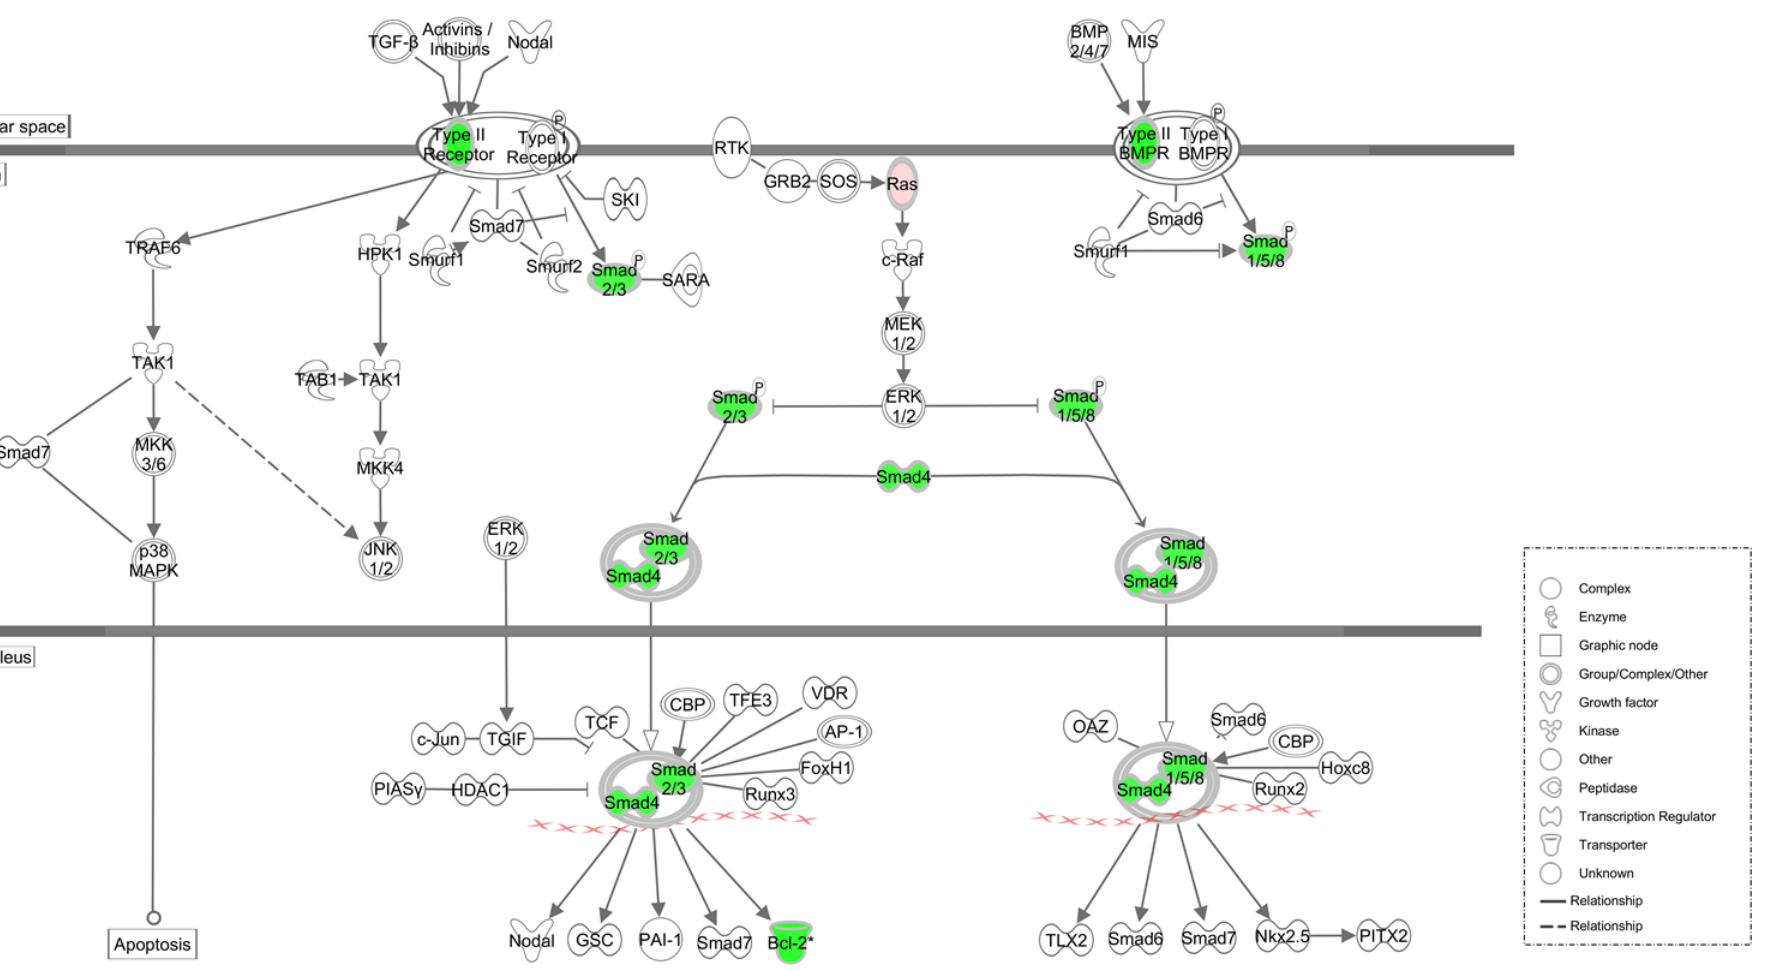
Figure 4. Schematic diagram of TGF-β and BMPs signaling pathways in the anti-osteopenic effect of RDE: Down-regulated genes are in green, and up-regulated genes are in red. Genes in white were not specified but were used to establish network based on